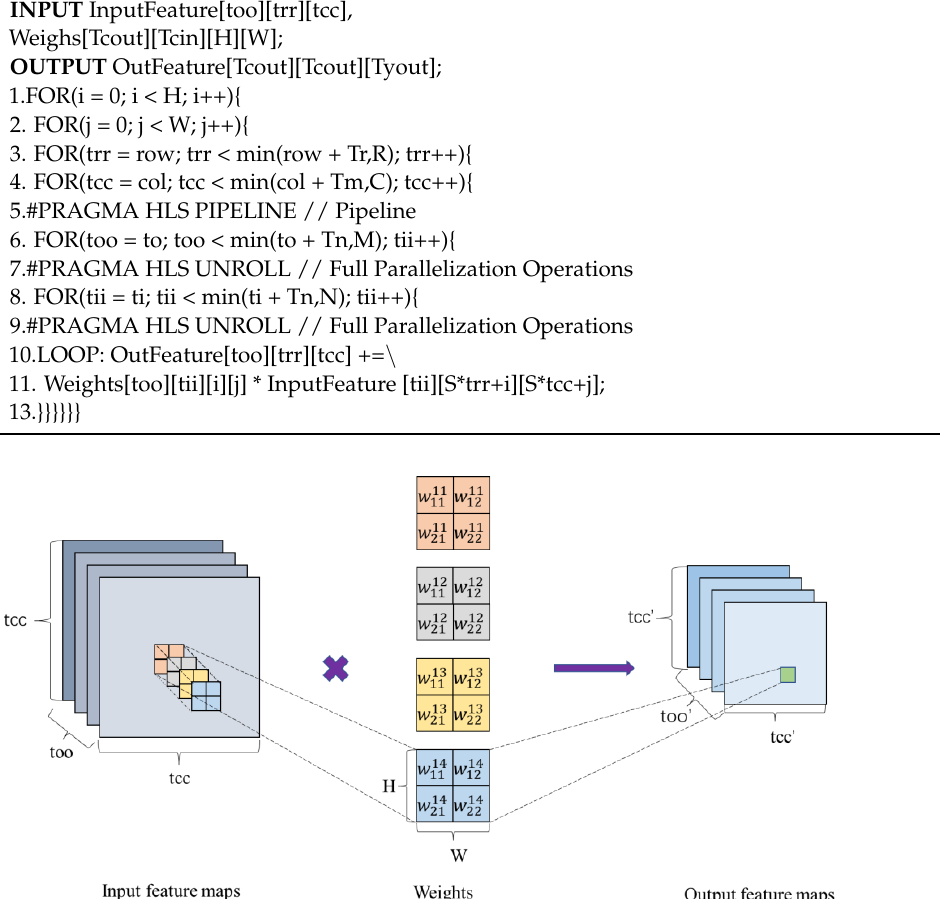
Figure 3. The calculation method of a convolutional layer. Algorithm 1. Convolutional activation unit parallel acceleration algorithm pseudocode